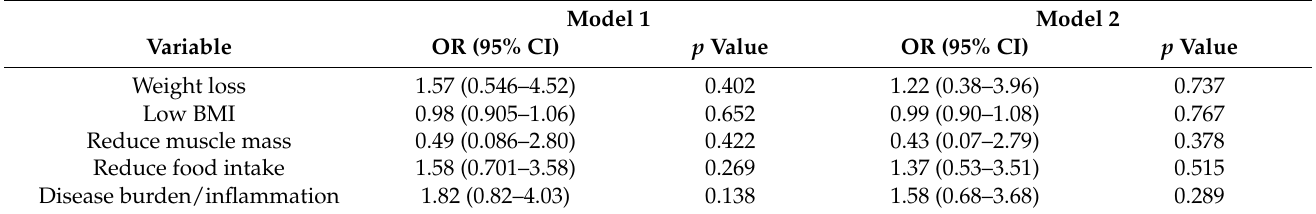
Table 8. Binary logistic regression for the association between GLIM criteria and the prevalence of microvascular